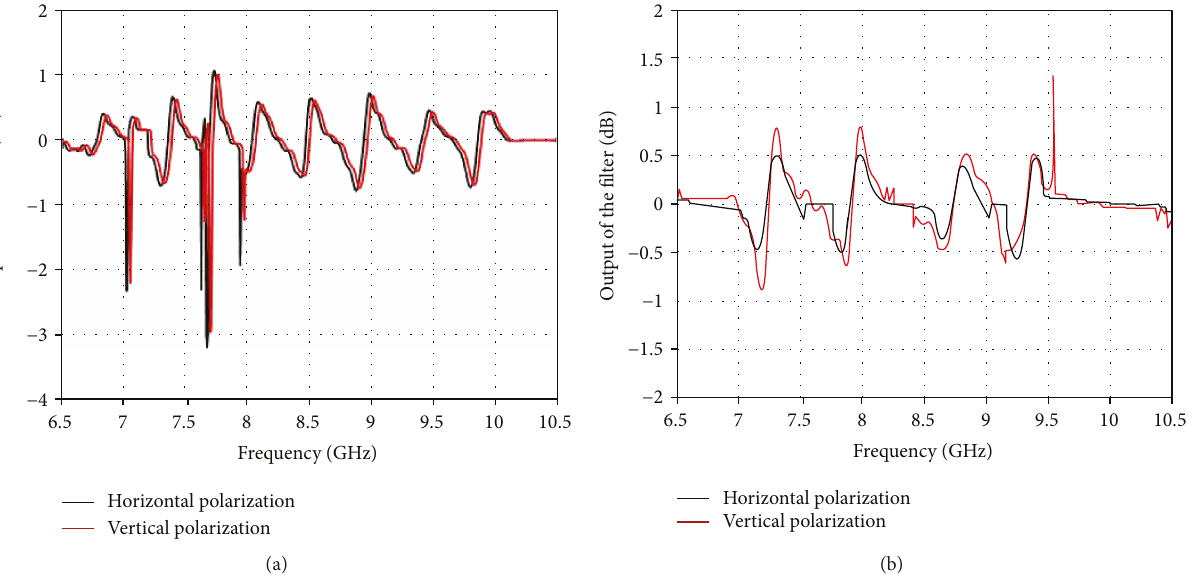
Figure 7: The fi lter output for the horizontal and vertical components of (a) code 111111111 and (b) code 010101010.